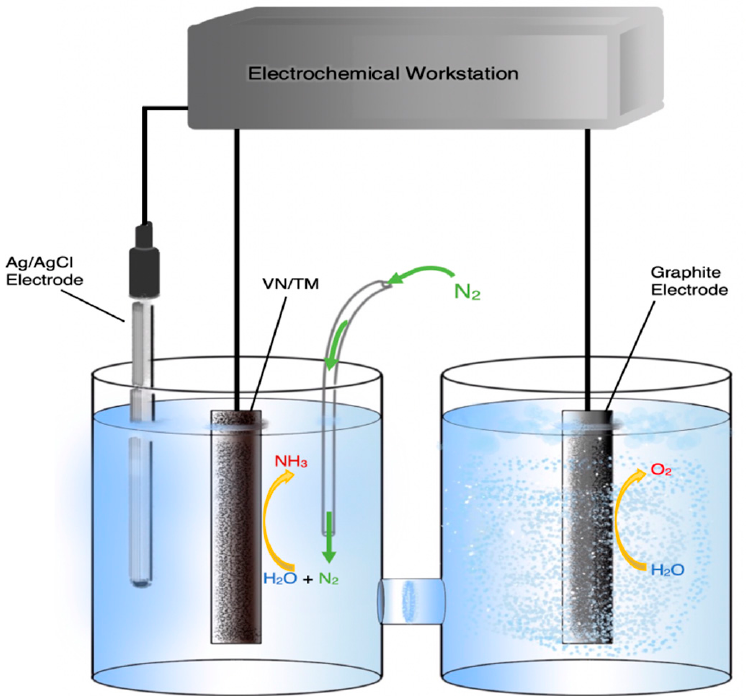
Figure 5. Schematic diagram of a HCl cell where NH 3 is produced on a VN/(titanium mesh) (VN/TM) catalyst via a Mars-van Krevelen mechanism. Redrawn from [40].